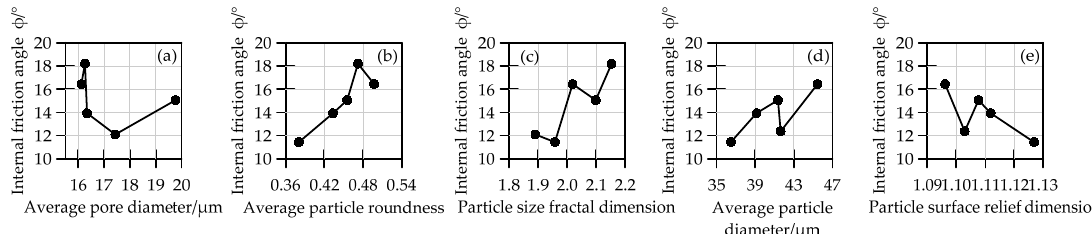
Figure 16. The curve of the internal friction angle of S2 versus the five most relevant microscopic parameters after F-T cycles: (a) D h , (b) R, (c) D ps , (d) D p , and (e) D pr.